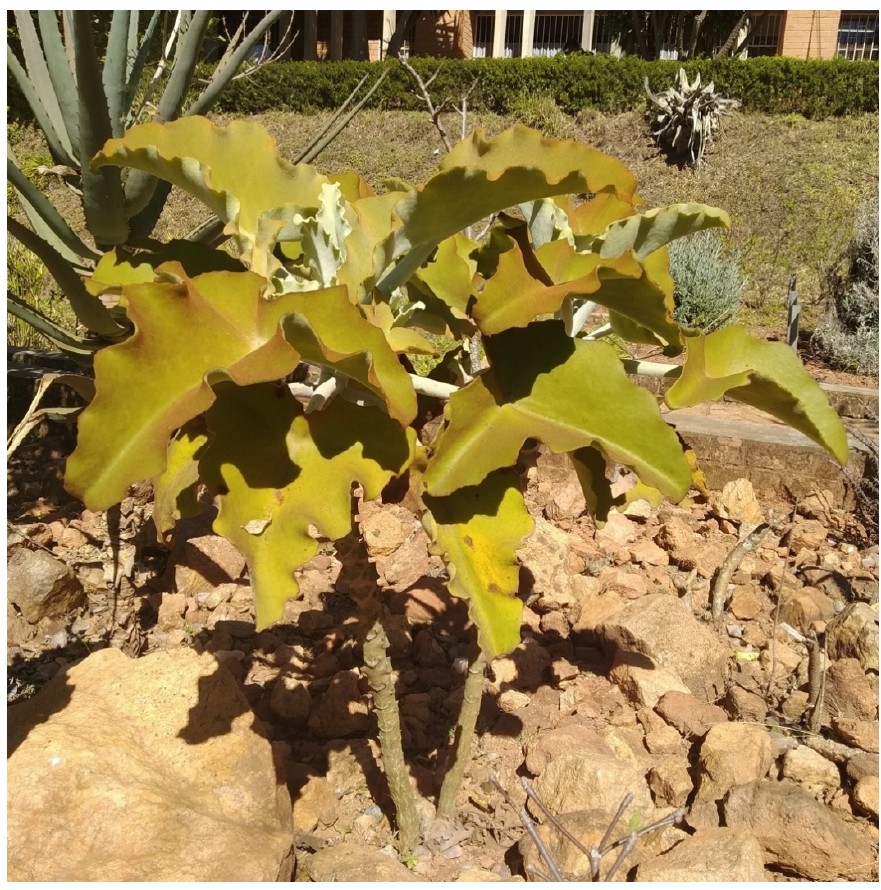
Figure 1. Kalanchoe beharensis cultivated at the Botanical Garden of the Department of Plant Biology and Ecology, University of Antananarivo (Photo V. Ramarosandratana).